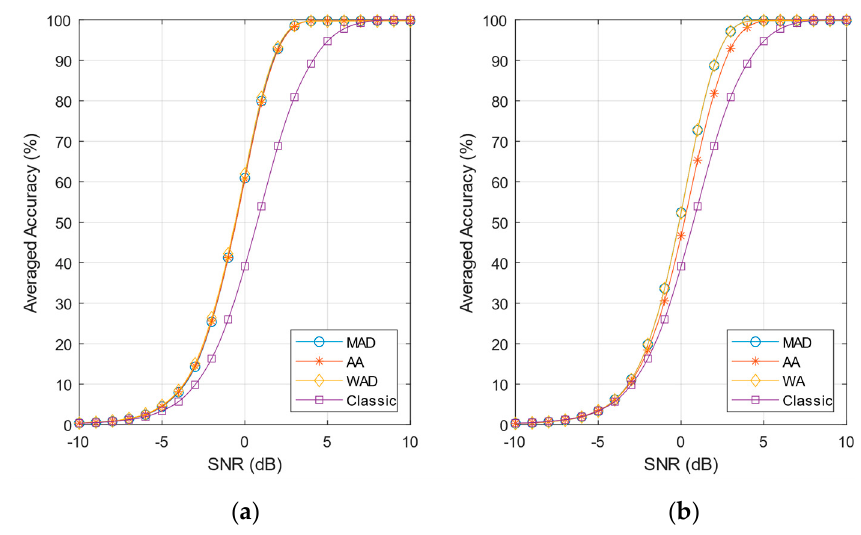
Figure 14. Averaged accuracy curves. ( a ) pre-norm and Classic SNEO; ( b ) post-norm and Classic SNEO. Table 7. Averaged detection performance at SNR = 0 dB and computational cost ( N = 8, k = 4).